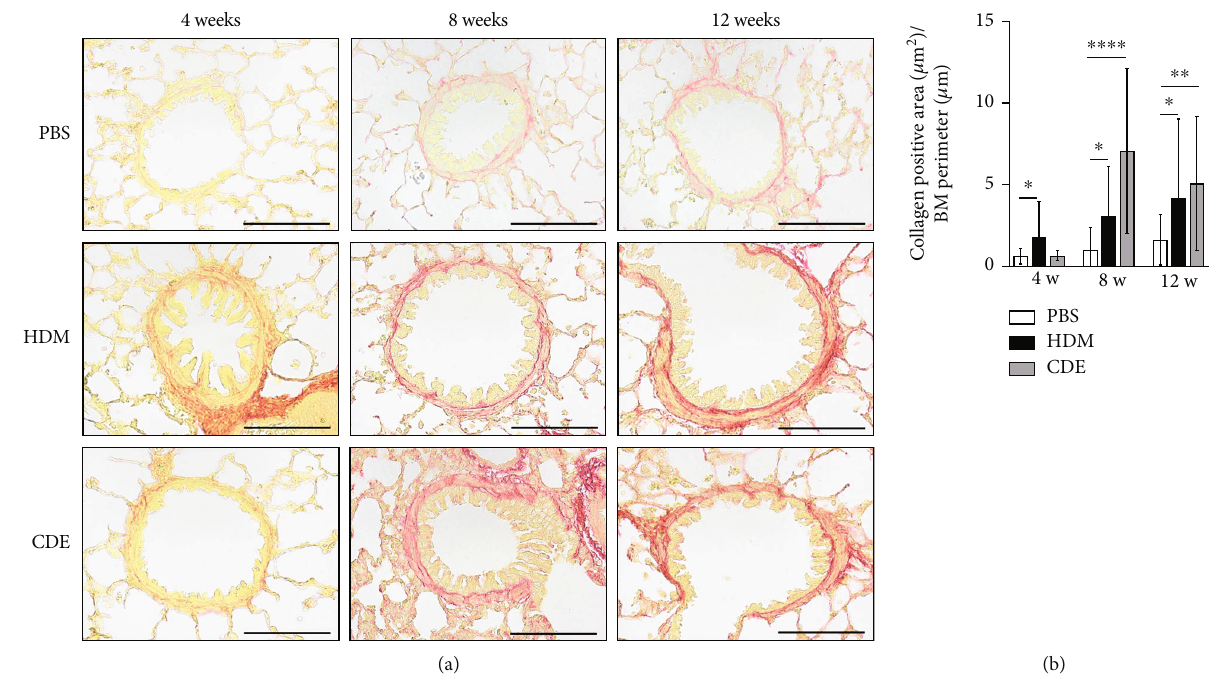
Figure 3: Guinea pigs exposed to HDM and CDE elicit hallmark features for airway remodelling. (a) Representative histological sections of Picro-Sirius Red-stained lungs and (b) analysis of collagen accumulation within the airway subepithelial region. Collagen-positive areas ( μ m 2 ) were adjusted by the BM perimeter ( μ m). Data are mean ± SD of n = 4 -5 animals per group. Scale bars correspond to 100 μ m. ∗ P < 0 : 05 , ∗∗ P < 0 : 01 , and ∗∗∗∗ P < 0 : 0001 . BM: basement membrane; HDM: house dust mite extract; CDE: cat dander extract. 4 weeks 8 weeks